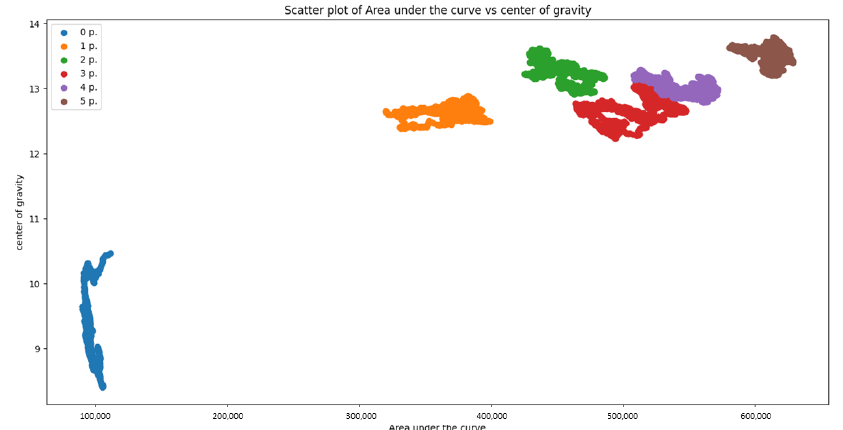
Figure 5. Scatter plot of the features Area under the curve vs. Center of gravity -for the different classes in Room A with maximum 5 people.